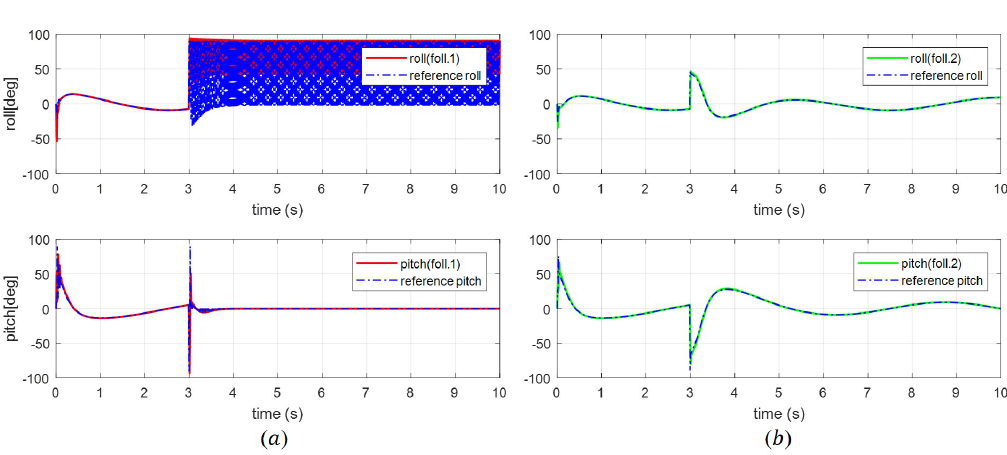
Figure 22. The reference attitude angles with disturbance: ( a ) backstepping-based formation control with SAA; ( b ) proposed formation control with the state transformation